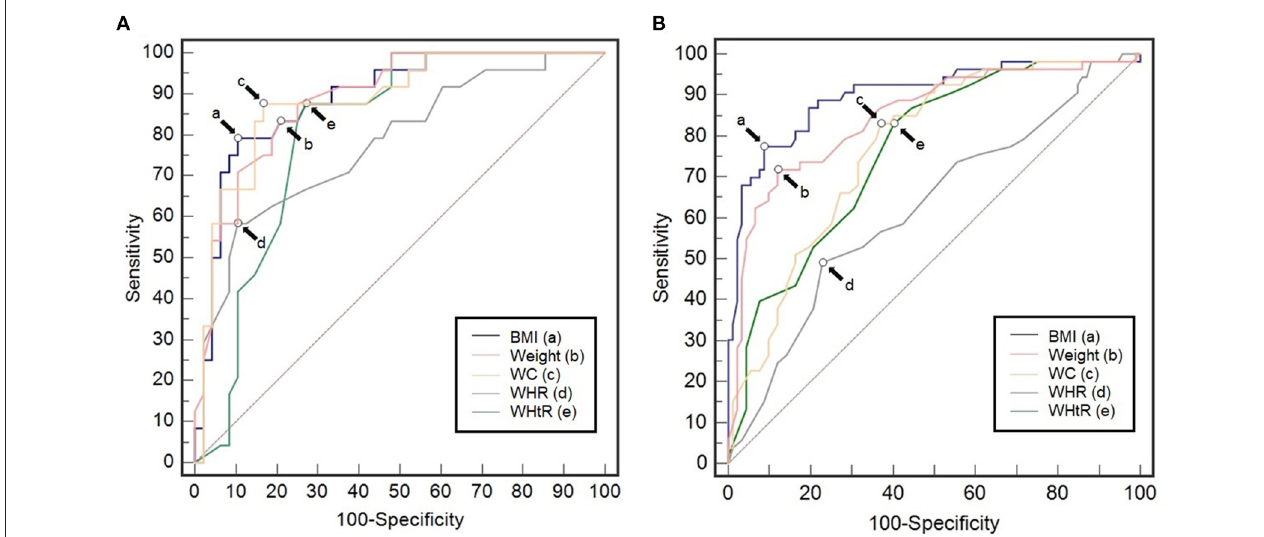
FIGURE 1 | Receiver operating characteristics curves of body mass index, body weight, waist circumference (WC), waist-to to-hip ratio (WHR), and waist-to to-height ratio (WHtR) in the prediction of anemia among young adults of Malaysia (A) men ( n = 113); a = 20.65, b = 62, c = 76, d = 0.79, e = 0.45, and (B) women ( n = 132); a = 19.7, b = 49.5, c = 71, d = 0.74, e =